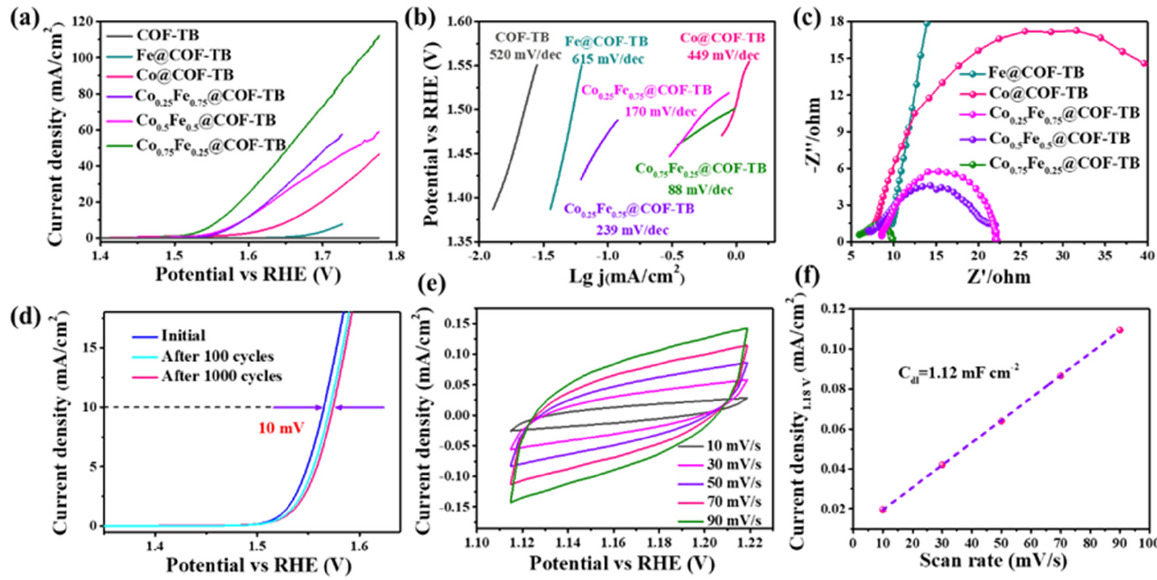
Figure 4. ( a ) LSV curves toward OER of COF − TB, Co x Fe 1 − x @COF − TB (x = 0, 0.25, 0.5, 0.75, 1); ( b )